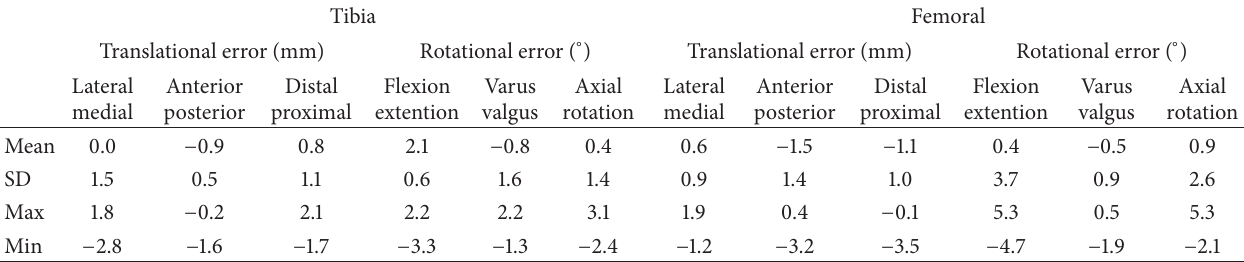
Table 1: Translational and rotational error values in UKA implant placement (𝑛 = 9) .